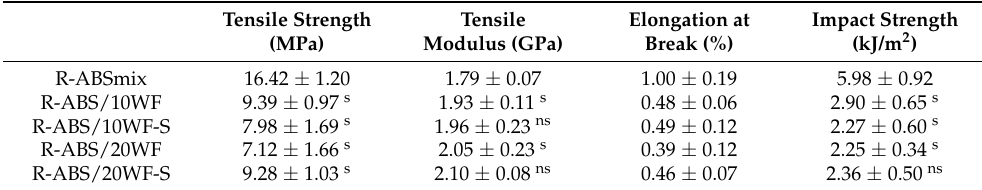
Table 4. Mechanical properties of the wood fiber composites and